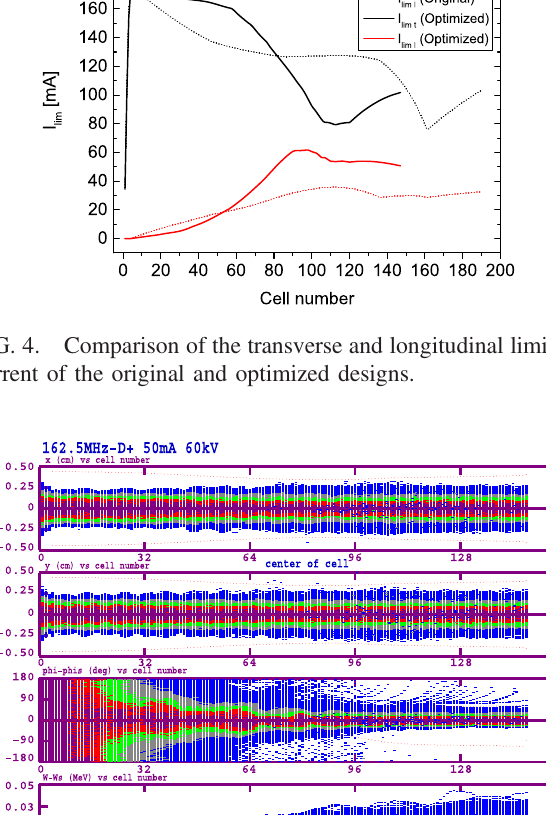
TABLE I. Design parameters of the deuteron